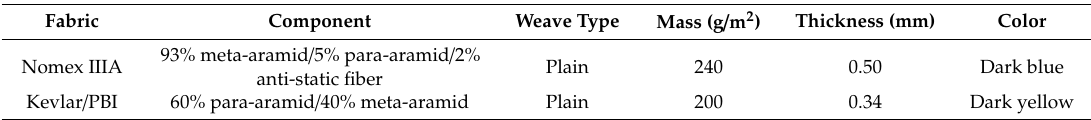
Table 1. Basic properties of the specimens.